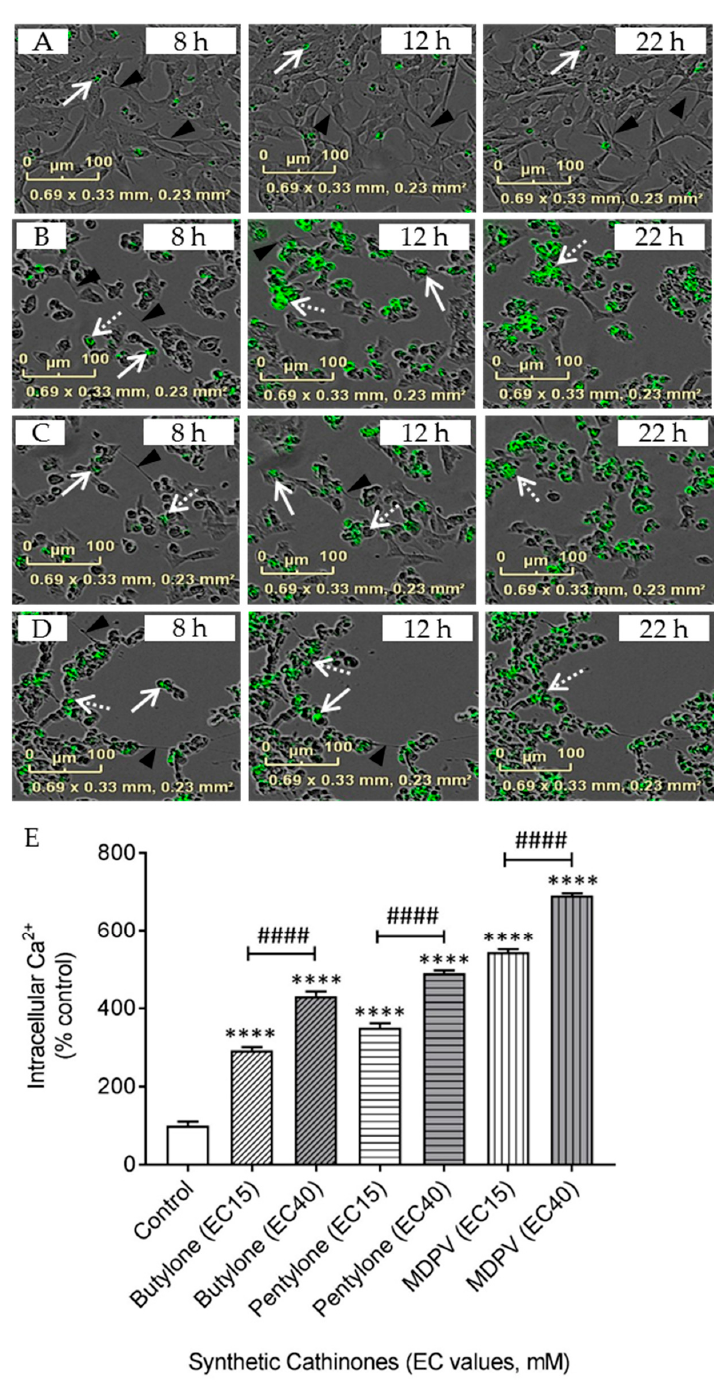
Figure 6. Representative merged images of Cal-520AM staining in ( A ) the control, ( B ) EC 15 butylone, ( C ) EC 15 pentylone, and ( D ) EC 15 MDPV using the IncuCyte ® live-cell imaging system (scale bar: 100 µ m) at di ff erent time points (8, 12, and 22 h) after drug treatments. Triangular arrowhead shows cell axons, the filled arrow shows the focal distribution, and the broken arrow shows the dispersed distribution of Cal-520 AM staining. ( E ) Quantification of Cal-520 AM fluorescence after 24 h of treatment of EC 15 and EC 40 for butylone, pentylone, and MDPV. Data shown in panel E are Mean ± SD obtained from four independent experiments. #### p < 0.0001 vs. EC 15 butylone, EC 15 pentylone and EC 15 MDPV. Di ff erent to the control; **** p < 0.0001.